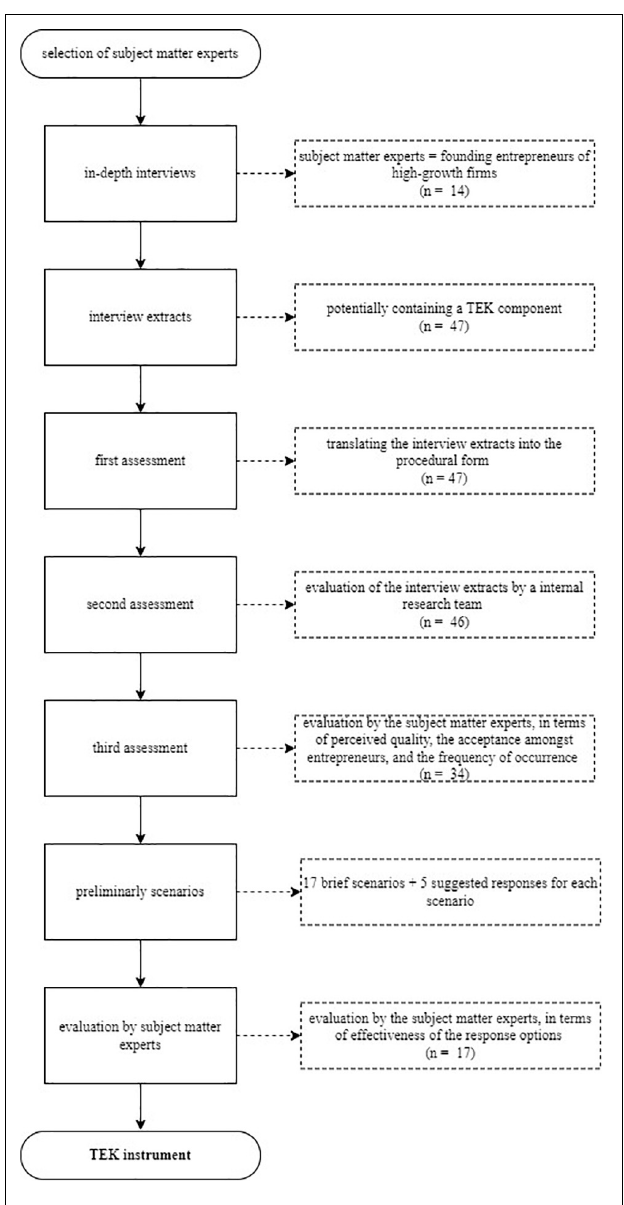
FIGURE 2 | Situational judgment test (SJT) development